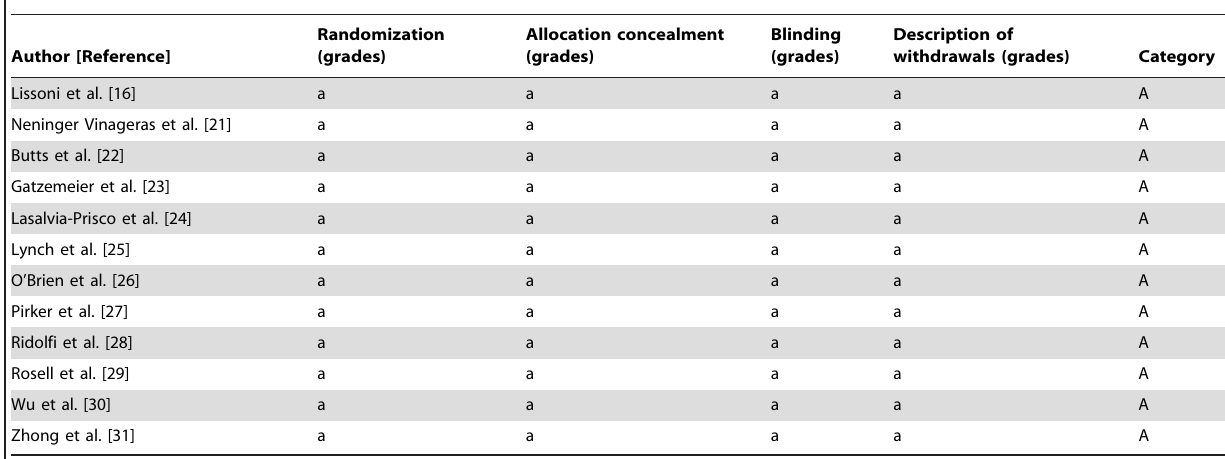
Table 2. Jadad Scale for the 12 randomized controlled studies.